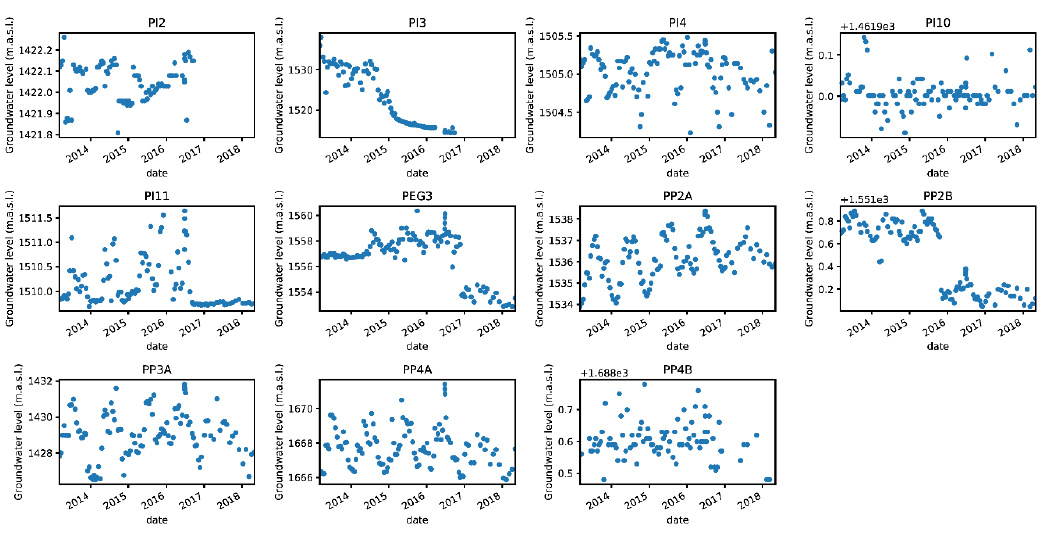
Figure A7. Time series plot of 11 groundwater observation points.